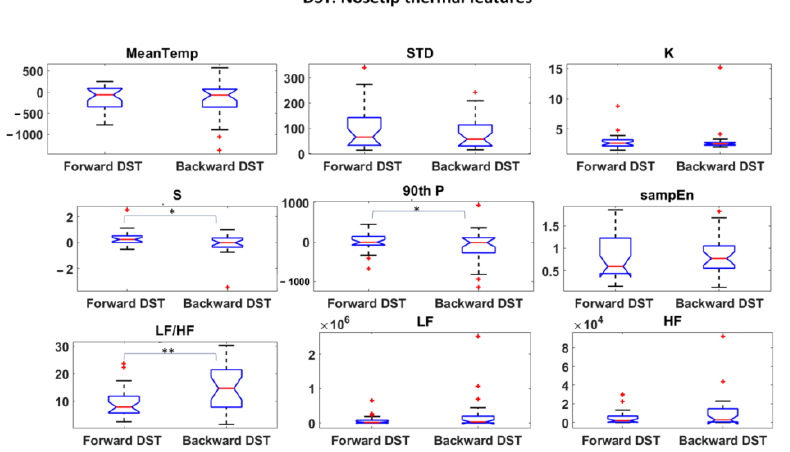
Figure 6. Thermal features relative to Nosetip ROI extracted during DST (* p < 0.05; ** p < 0.01). Outliers are represented with red crosses. The titles of the single plots refer to abbreviations of features described in Section 3.3.